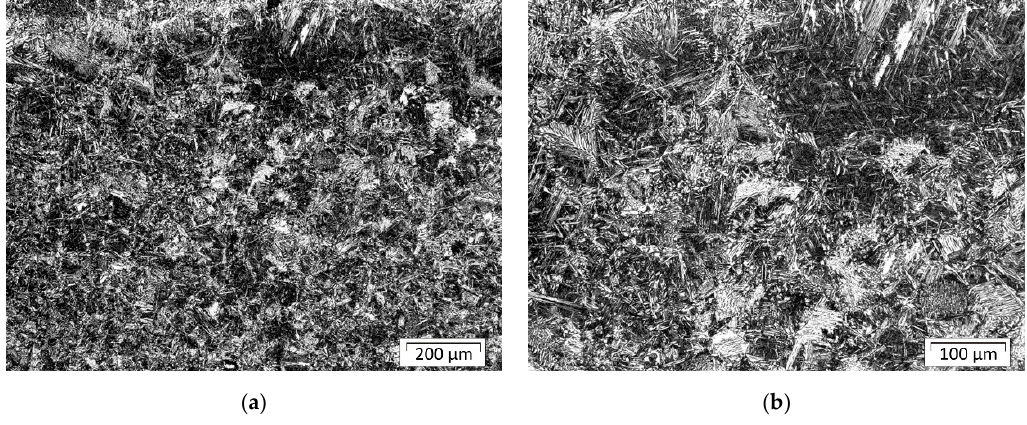
Figure 14. Sample B: ( a ) the structure of the HAZ between the first and second bead; ( b ) the structure of the HAZ between fifth and third bead.